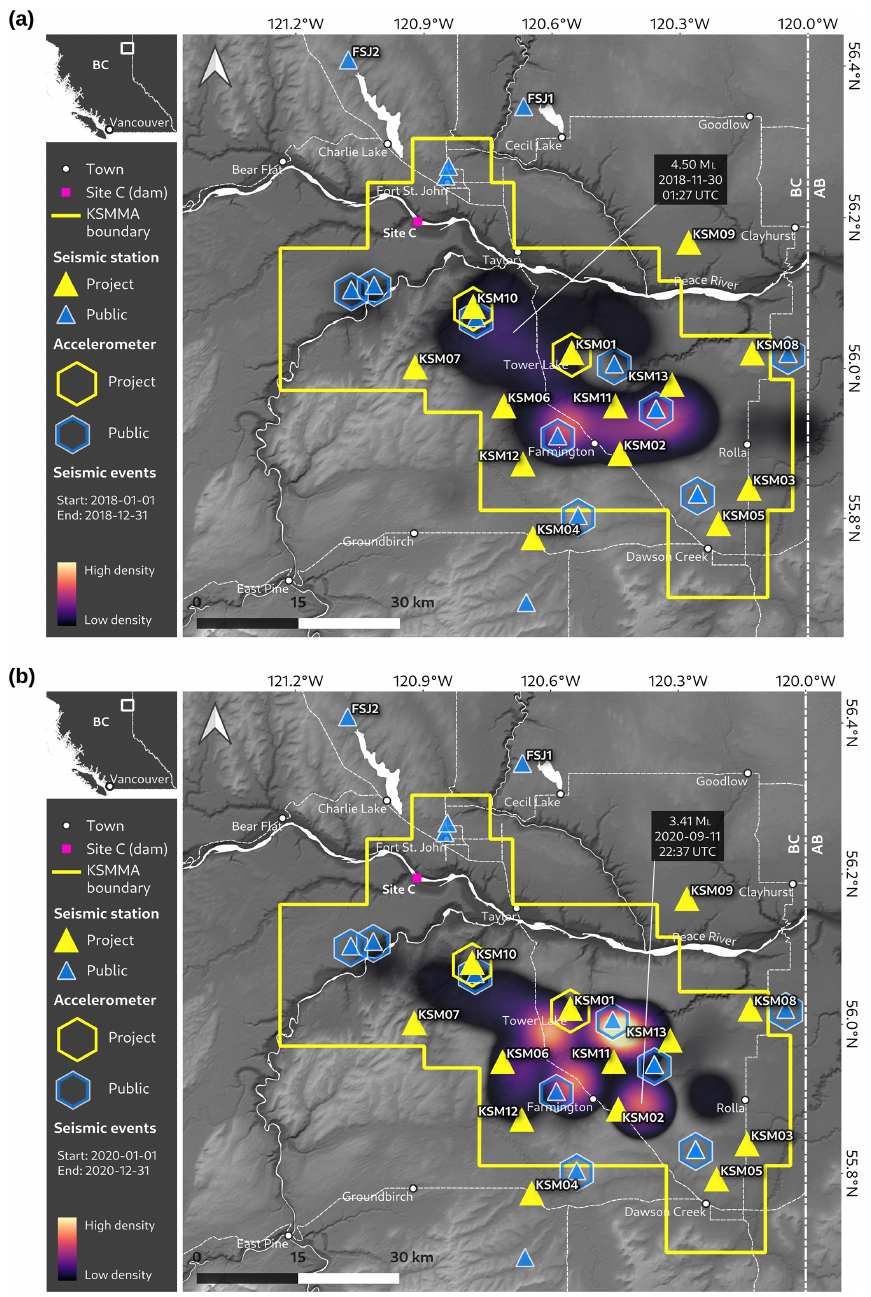
Figure 2. Spatial locations of seismicity concentrations within the KSMMA. A higher density of seismic events is indicated by brighter colours, a lower density by darker colours and no seismicity by grey. Densities displayed in (a) and (b) are directly comparable, i.e. the absolute seismic density is the same in both subplots. The outline of the KSMMA boundary is shown in yellow, public seismic monitoring stations as blue triangles, the newly installed EO network as yellow triangles and co-located accelerometers as hexagons. FSJ1 and FSJ2 are also part of the EO network but were installed in 2018. FSJ1 was decommissioned on 26 August 2020 but is shown for completeness as it was used in seismic analysis prior to this. The largest measured magnitude event within the KSMMA boundary for each year is marked. (a) Seismic events reported by NRCan between 1 January and 31 December 2018 (inclusive) (Visser et al., 2020). Note: although the new dense array was not installed at this time, it is shown on the map for reference. The largest event in 2018, occurring on 30 November north of Tower Lake, is shown ( M L 4.5). (b) Seismic events recorded by the newly installed EO network (and incorporating data from public stations) from 1 January to 31 December 2020 (inclusive). The largest magnitude event, occurring on 11 September 2020, is indicated ( M L 3.4, Hutton and Boore, 1987; M L 3.1, Babaie-Mahani and Kao, 2020). Figure courtesy of Thomas H. A. Swinscoe, University of Calgary and developed using QGIS (https://qgis.org/en/site/about/index.html, last access: 15 February